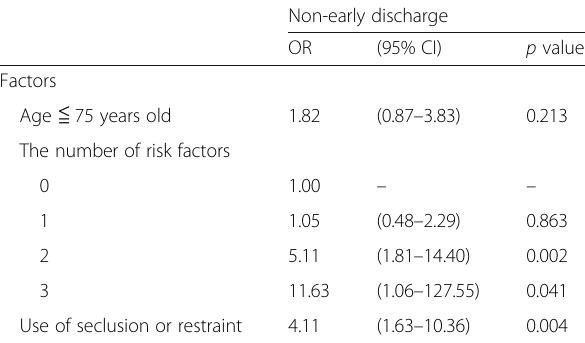
Table 4 Odds ratios (OR) and 95% confidence intervals (95% CI) for various factors associated with non-early discharge Non-early